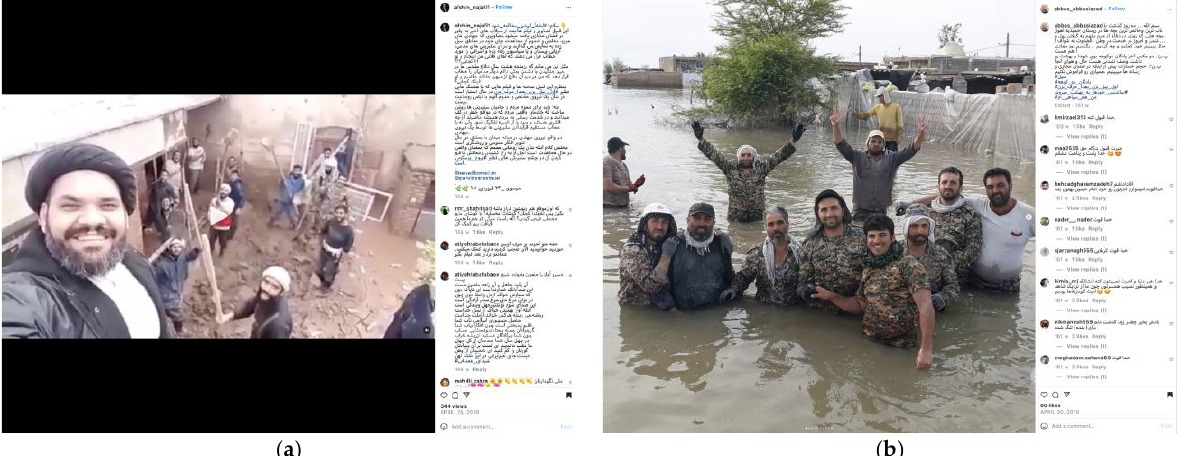
Figure 1. Images shared with the hashtag “First shovel, then complain”: ( a ) The video selfie made by Seyyed Komeil Musavi, which is reposted by an Instagram user to criticize it as an act of pretention. The original post by Seyyed Komeil Musavi is not available anymore. Source: https://www.instagram.com/p/BwuiOPIgkTg/ (accessed on 17 May 2021). ( b ) Image with the same hashtag, taken by a group of members of the IRGC in flood-stricken areas in south-western Iran. Source: https://www.instagram.com/p/Bw4Ts3tAAiK/?utm_source=ig_web_copy_link (accessed on 17 May 2021).